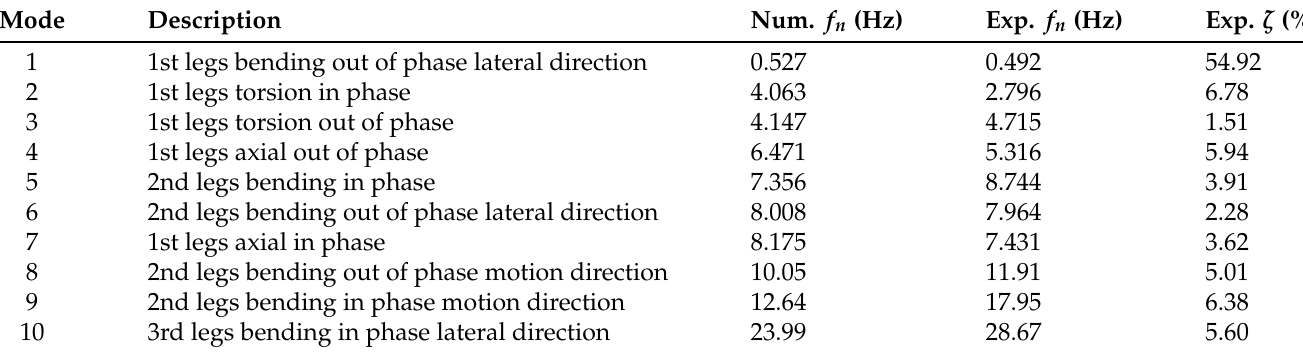
Table 1. Rollo numerical natural frequencies and experimental natural frequencies and damping